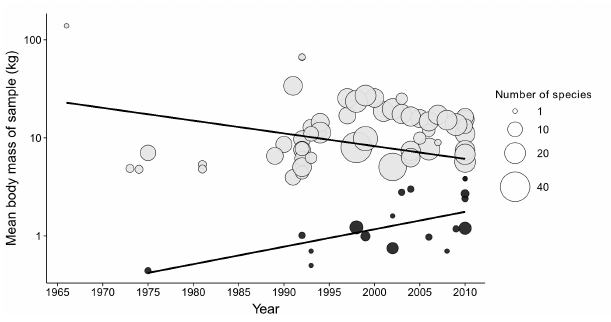
Fig. 2 . Mean body mass indicator for mammals (gray circles) and birds (black circles) in West and Central Africa. Circles represent offtake samples and are scaled by the number of species harvested within each sample; lines are fitted using linear mixed effects models. Samples are plotted on a logarithmic scale. Note that excluding outliers, 1966 for mammals and 1975 for birds, did not substantially alter the fitted